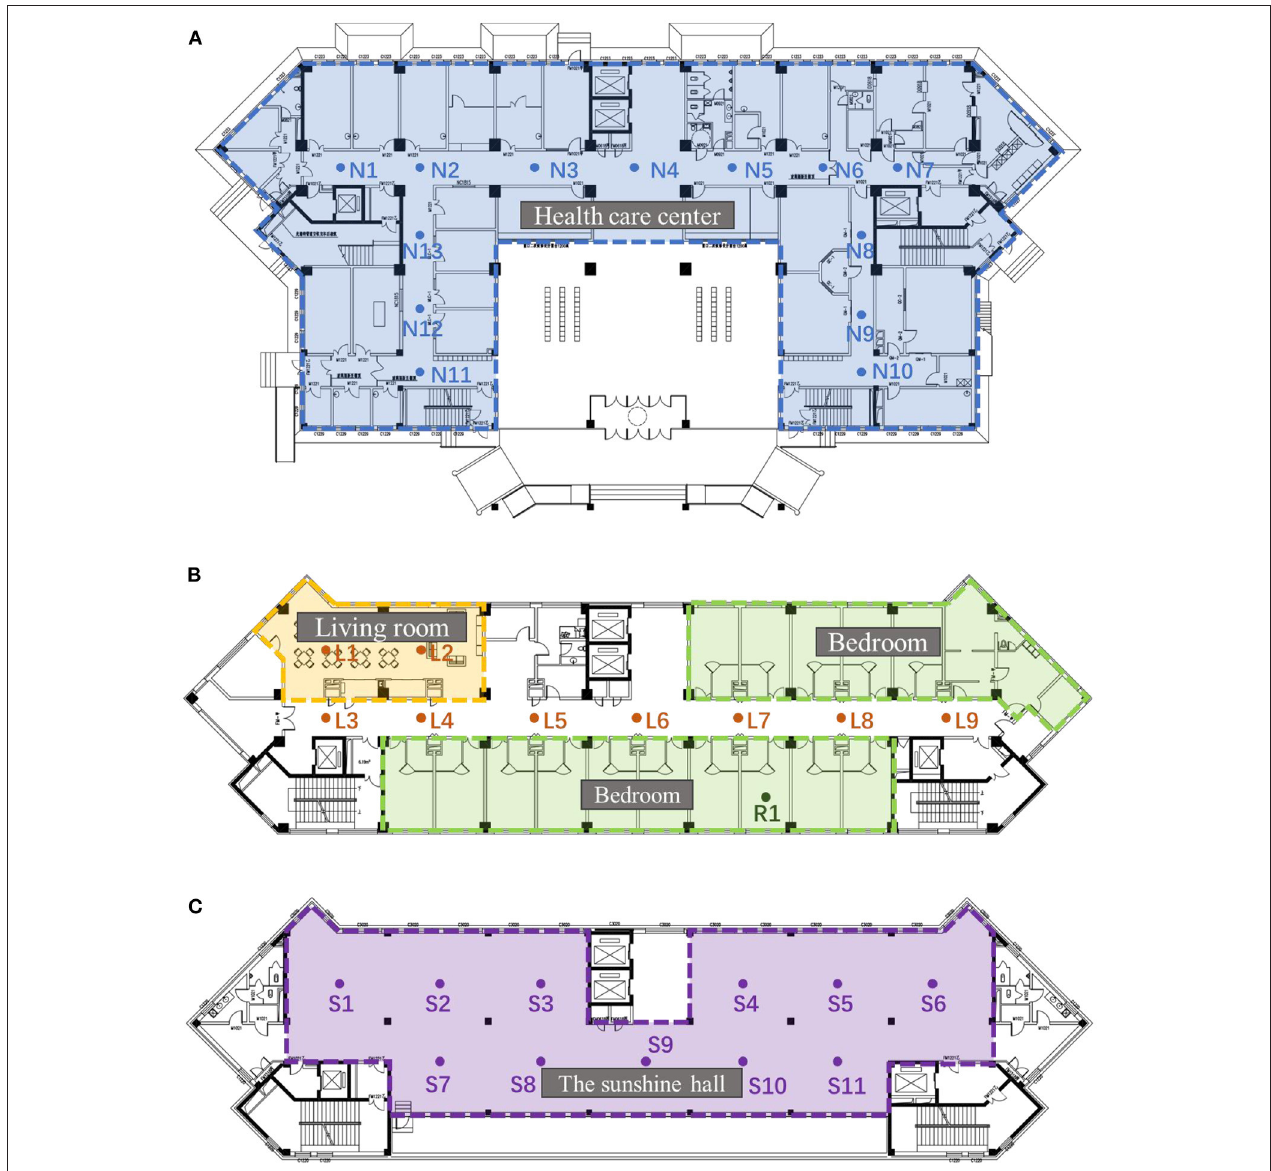
FIGURE 1 | Layout of different space (A) Healthcare spaces layout (B) Living space (C) Sunshine Hall.